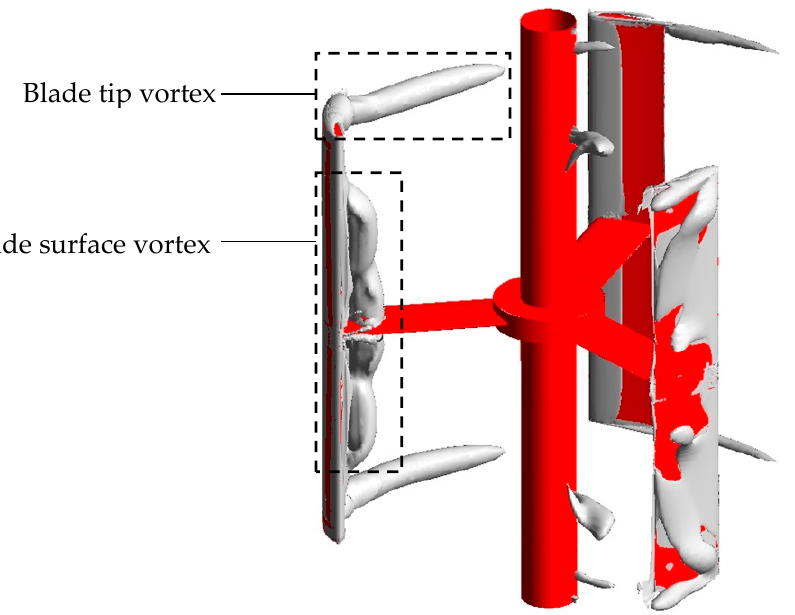
Figure 7. Vortex structures of the turbine ( λ = 1.5).